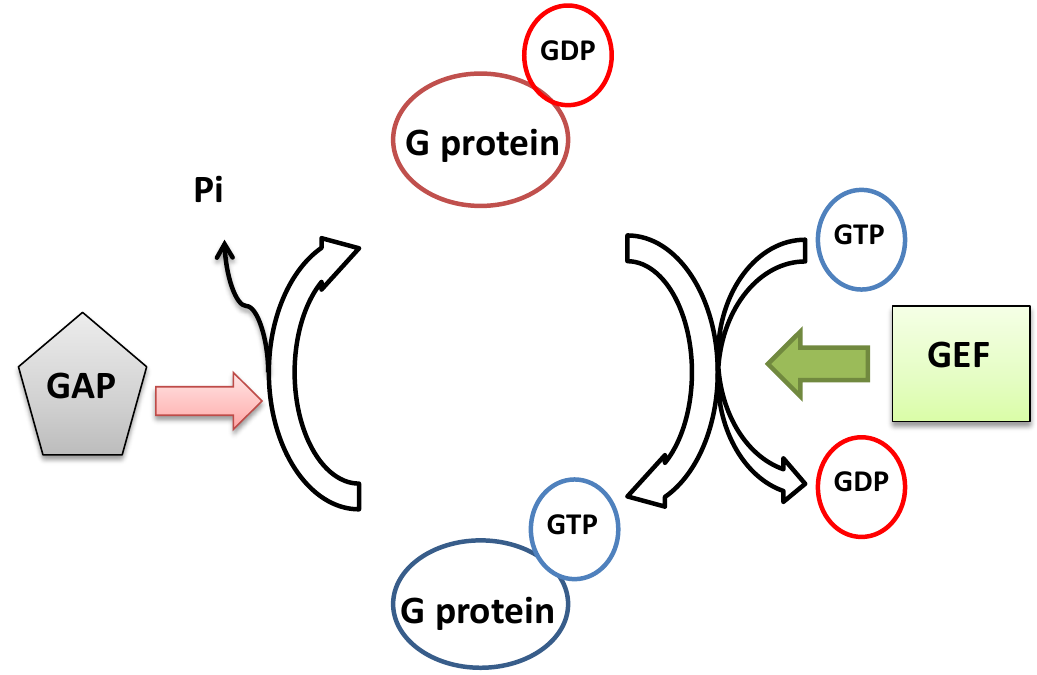
Figure 4. Monomeric small GTP-binding proteins can cycle between different guanine nucleotide binding states. (G protein in this figure = monomeric GTP-binding